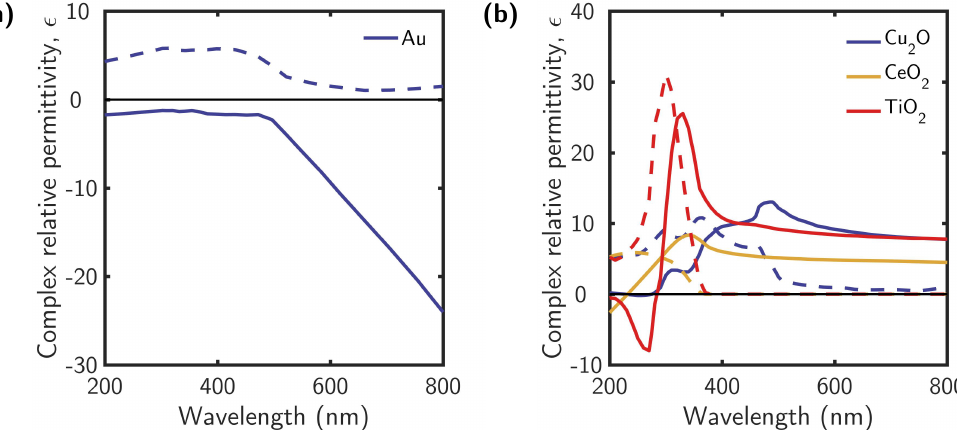
Figure 3. Complex dielectric function (cid:101) = (cid:101) r + i (cid:101) i of ( a ) Au and ( b ) Cu 2 O (blue), CeO 2 (yellow) and TiO 2 (red). The real (cid:101) r and imaginary part (cid:101) i of the complex dielectric function are plotted with solid and dashed lines, respectively. The optical constants have been taken from different sources of the literature: Au [30], Cu 2 O [31], CeO 2 [32] and TiO 2